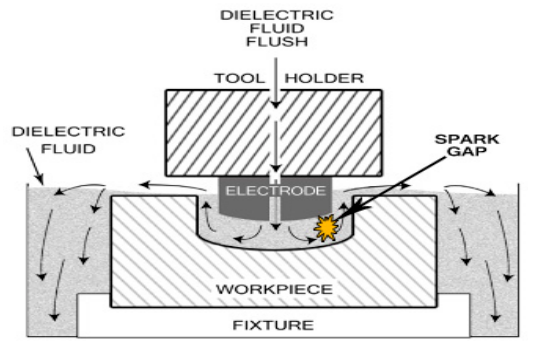
Figure 1. Die sinker